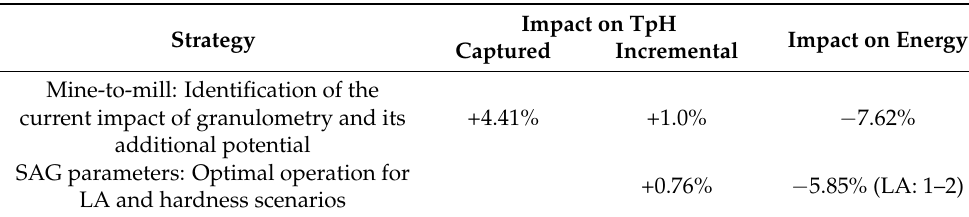
Table 4. The impact of the ML model on the SAG grinding system’s operational strategies (LA: liner age).